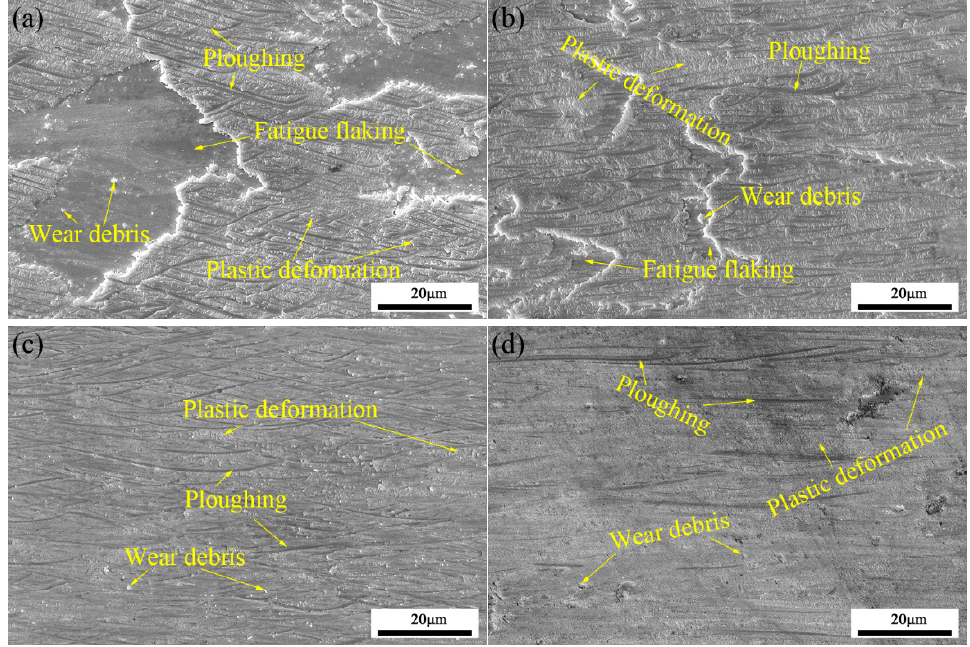
Figure 6. Typical wear scar morphology of the Blank/10 specimen ( a ), CRR/10 specimen ( b ), Blank/20 specimen ( c ), and CRR/20 specimen ( d ).